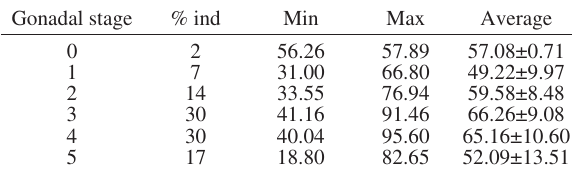
Table 1. – Characteristics of the analysed C. chione specimens: per- centage of individuals at each gonadal stage (% ind) and minimum (Min), maximum (Max) and average (±SD) shell length